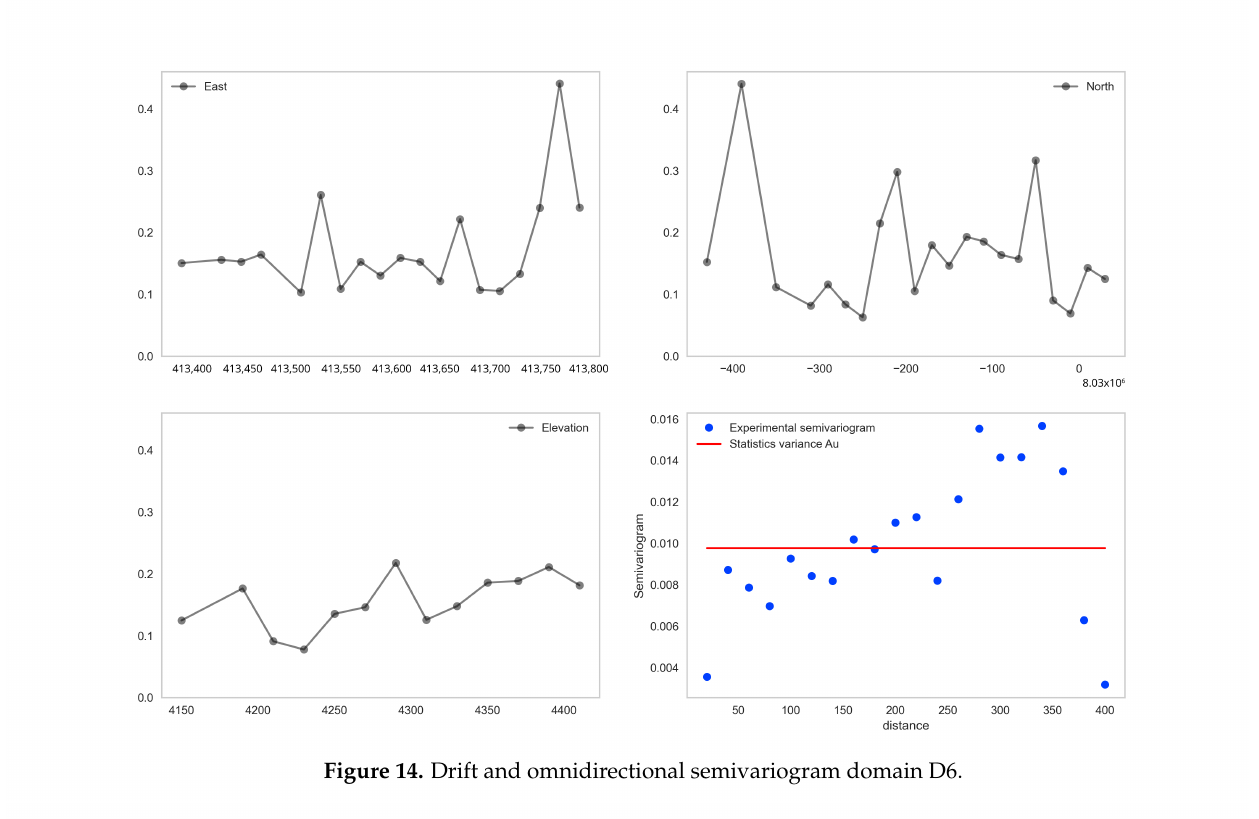
Figure 14. Drift and omnidirectional semivariogram domain D6.